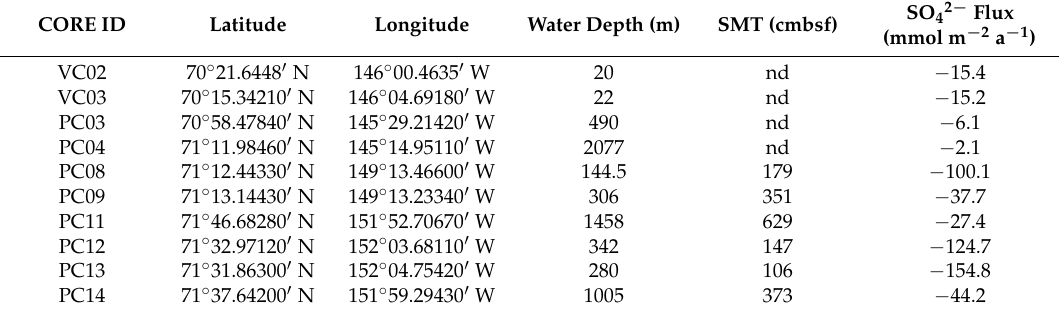
Table 1. A review of sediment coring locations, water column depth (m), estimated sulfate methane transition (SMT) depth in centimeters below sea floor (cmbsf), and calculated downward SO 42 − flux the vertical CH 4 flux estimate from sulfate (SO 42 − ) profiles. CH 4 and SO 42 − data are published in Coffin et al.